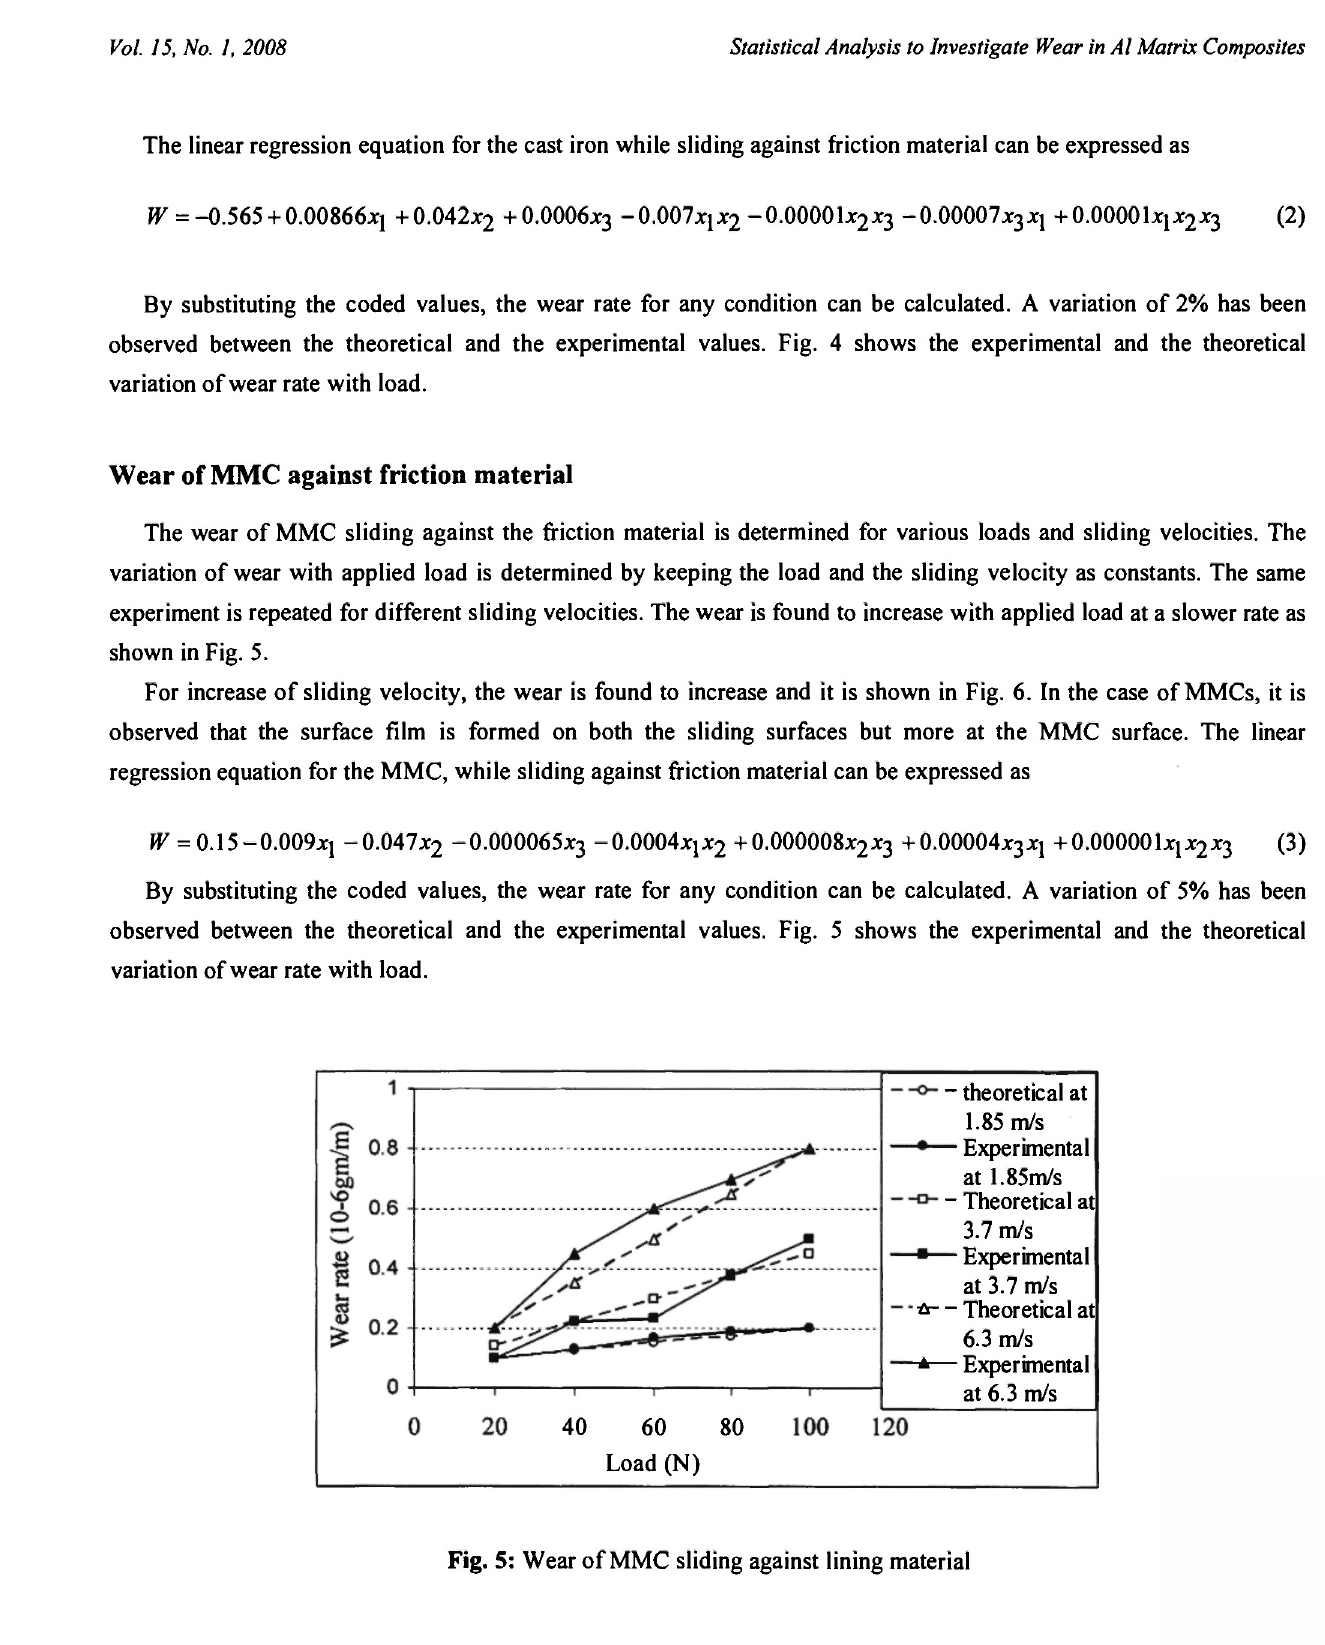
Fig. 5: Wear of MMC sliding against lining